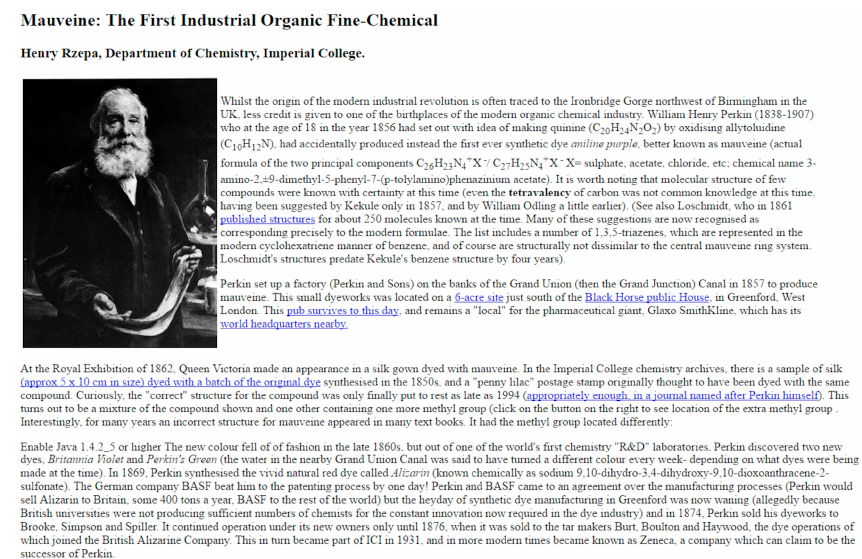
Figure 1. Screenshot of the first MOTM page for January 1996 about mauvine dye [4].